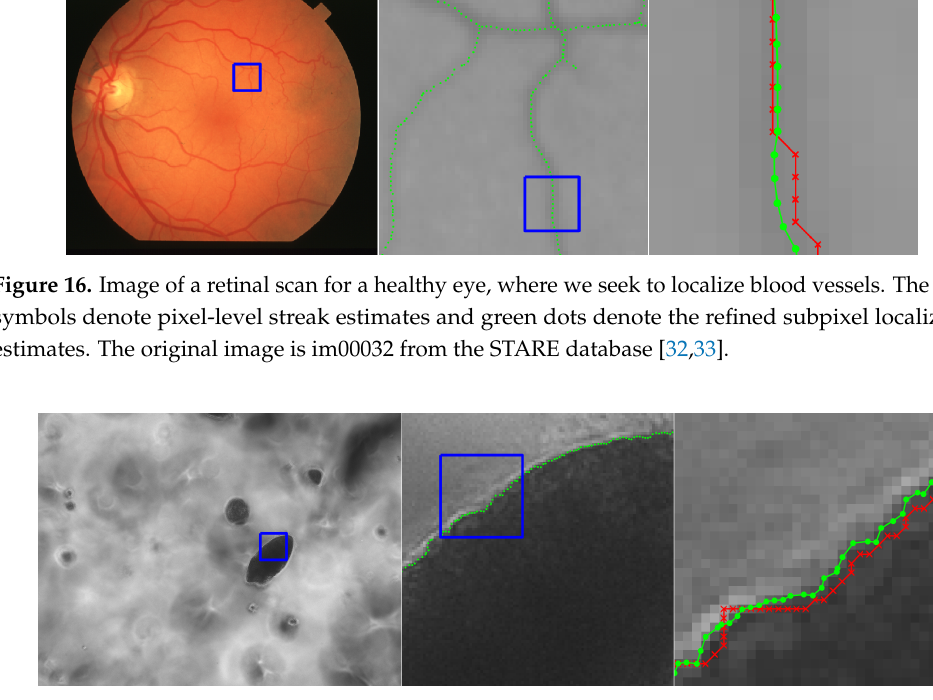
symbols denote pixel-level ×